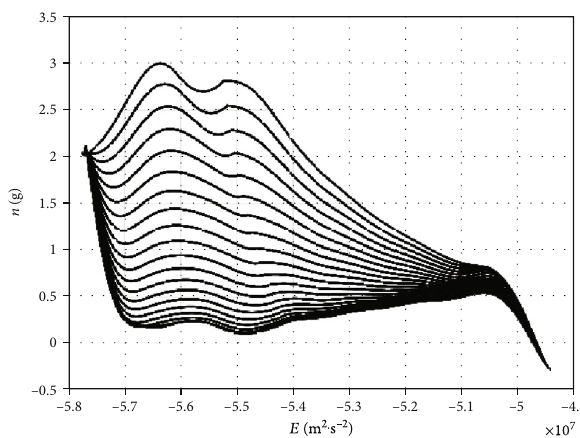
Figure 23: Heading angle pro fi les for Case 1.